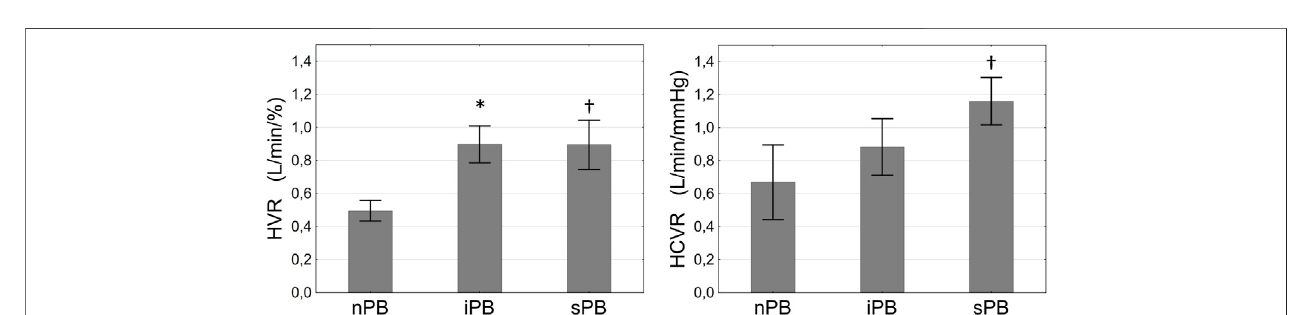
FIGURE 7 | Differences in hypoxic ventilatory response (HVR, left panel) and hypercapnic ventilatory response (HCVR, right panel) between patients with non- inducible (nPB), inducible (iPB) and spontaneous periodic breathing (sPB). Data are presented as SD ± SEM. * p < 0.05 for iPB vs. nPB, † p < 0.05 for sPB vs. nPB.